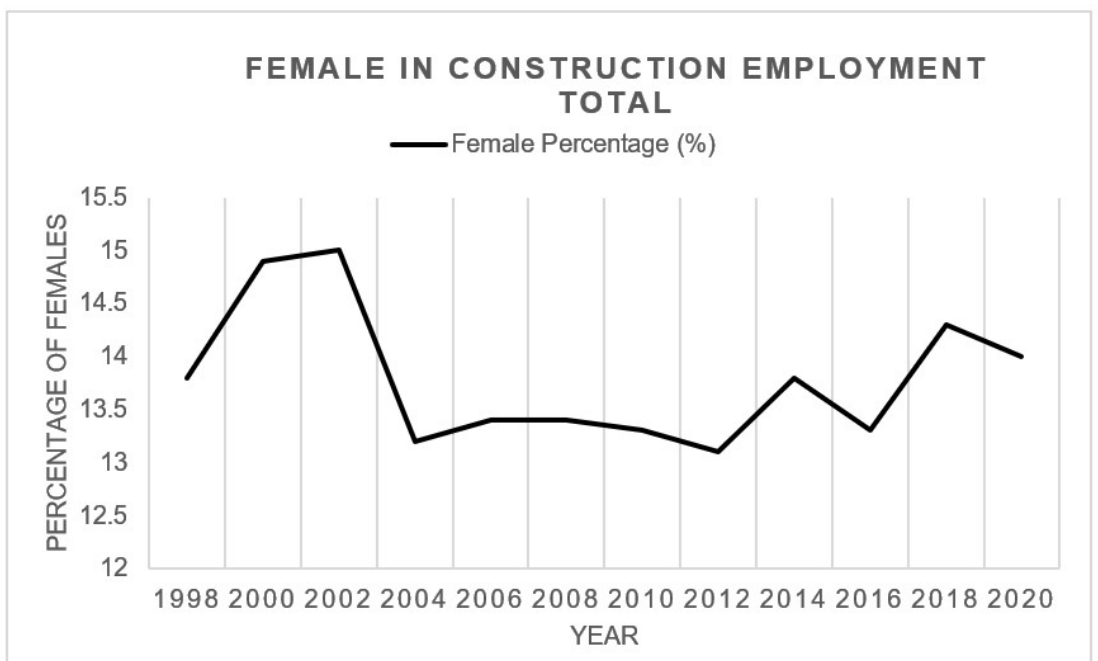
Figure 1. Total percentage of women in the Australian construction industry from 1998 to 2020 [9].